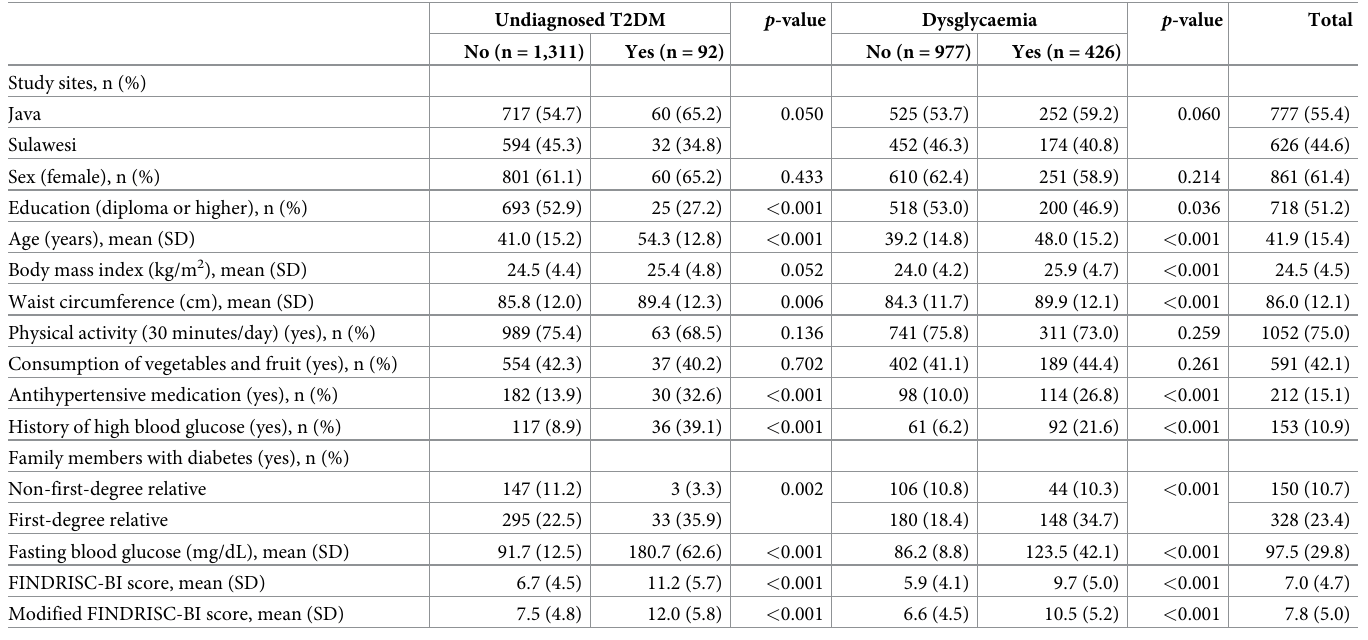
Table 1. Descriptive characteristics of study participants (n =